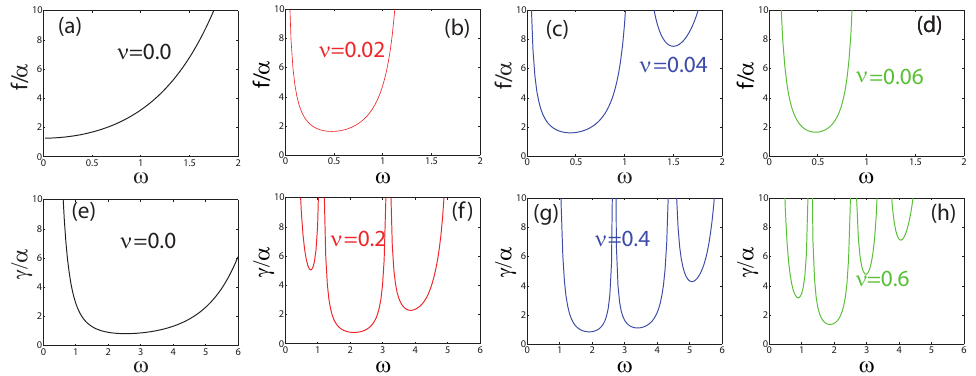
Figure 9. Melnikov critical curves η (cid:48) c = f / α ( a – d ) and η (cid:48)(cid:48) c = γ / α ( e – h ) versus frequency ω for the applied torques. ( a – d ) Periodically driven pendulum with a torque for the parameter values ν = 0, 0.02, 0.04, 0.06. ( e – h ) Parametrically excited pendulum with a torque for the parameter values ν = 0, 0.2, 0.4, 0.6. ( c , f – h ) It is possible to appreciate the effect of the torque in an asymmetric potential. In fact, there are some regions for which chaos does not appear. In these regions, the effect of the torque makes the motions of the pendula change from oscillations to rotations and vice versa. The curves are reliable in the limit of small forcing and